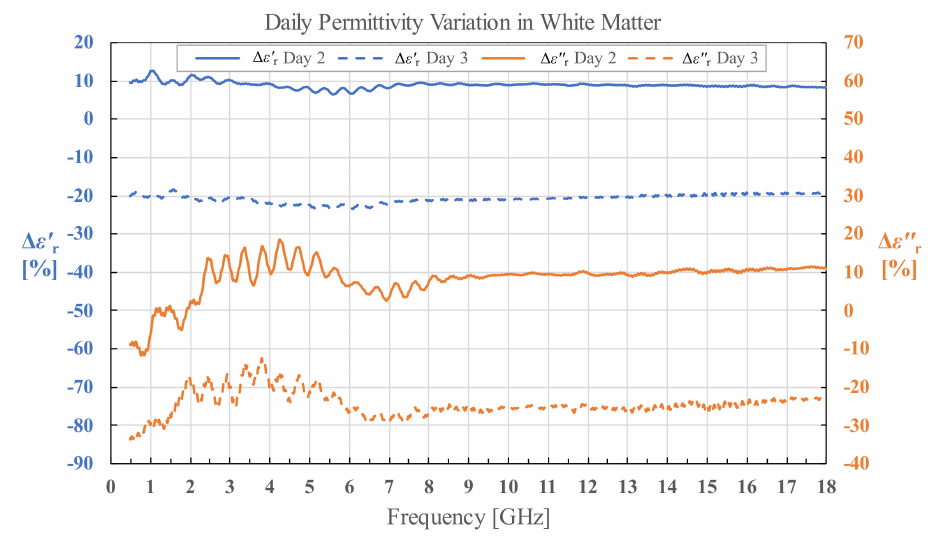
Figure 21. Permittivity change in human white matter for brain H1 on day 2 and day